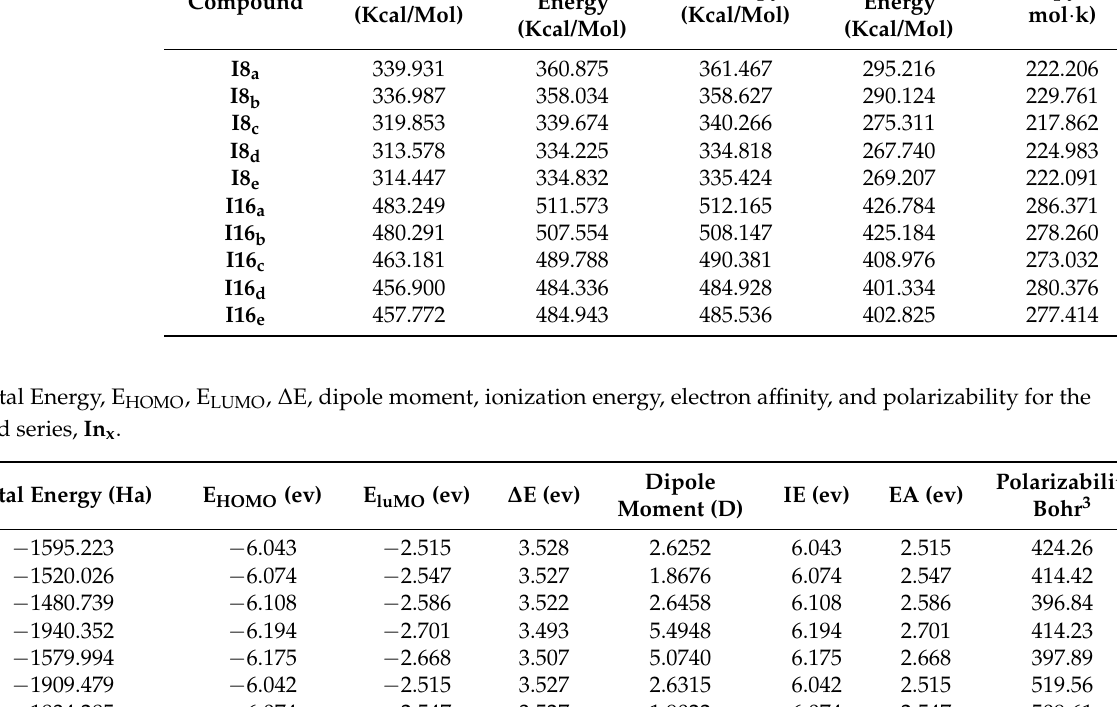
Table 3. Total Energy, E HOMO , E LUMO , ∆ E, dipole moment, ionization energy, electron affinity, and polarizability for the investigated series, In x